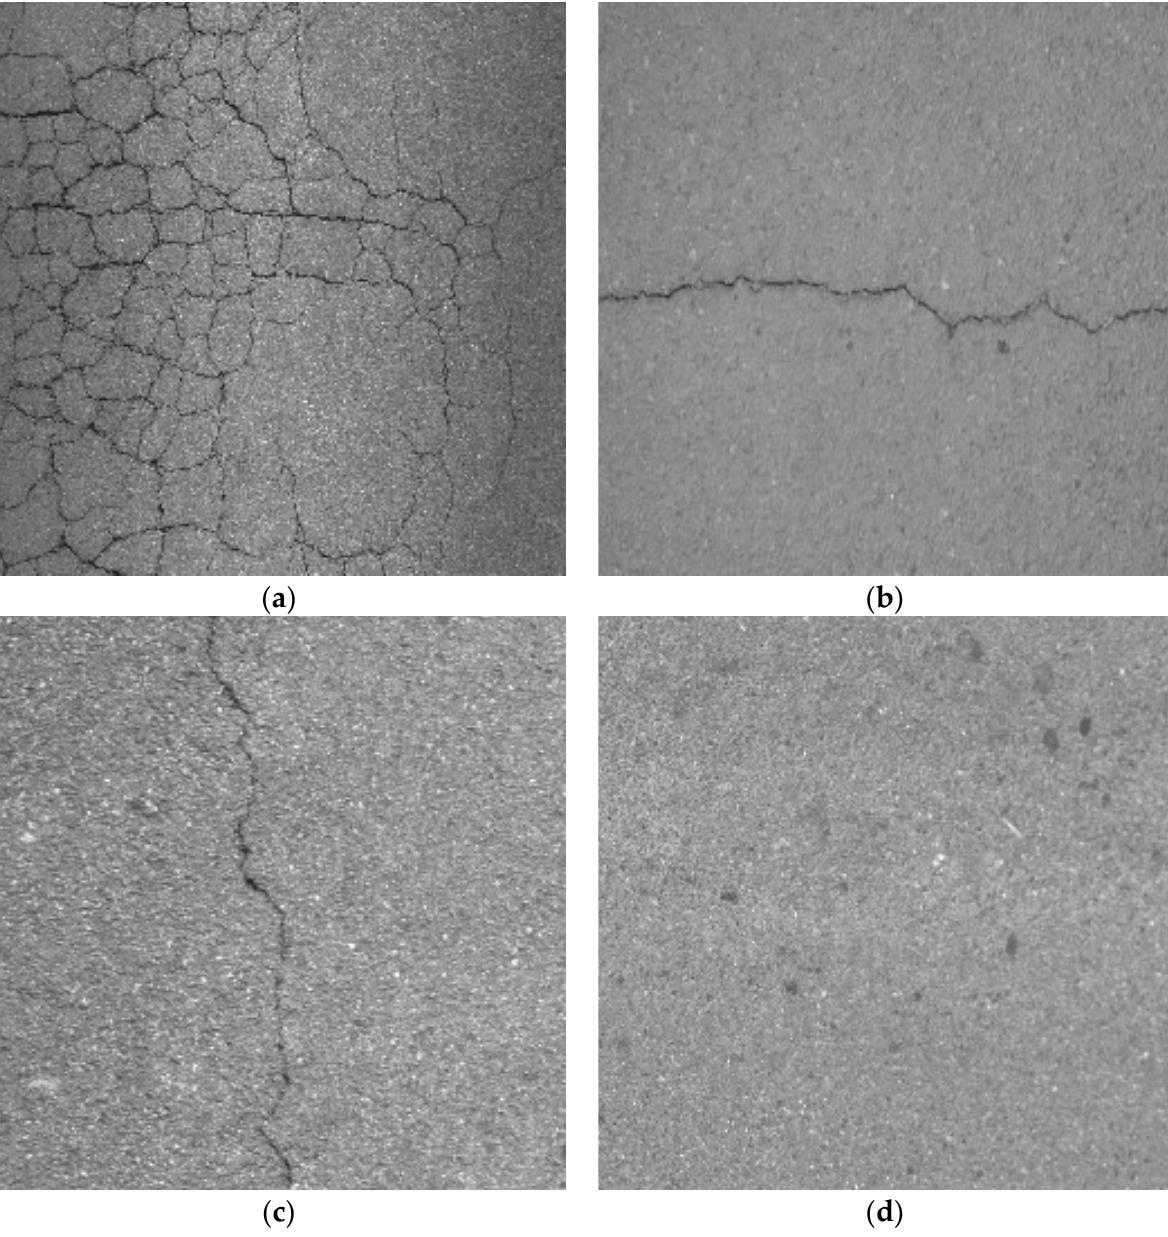
Figure 17. ( a ) Alligator crack; ( b ) longitudinal crack; ( c ) transverse crack; and ( d ) non-crack samples.